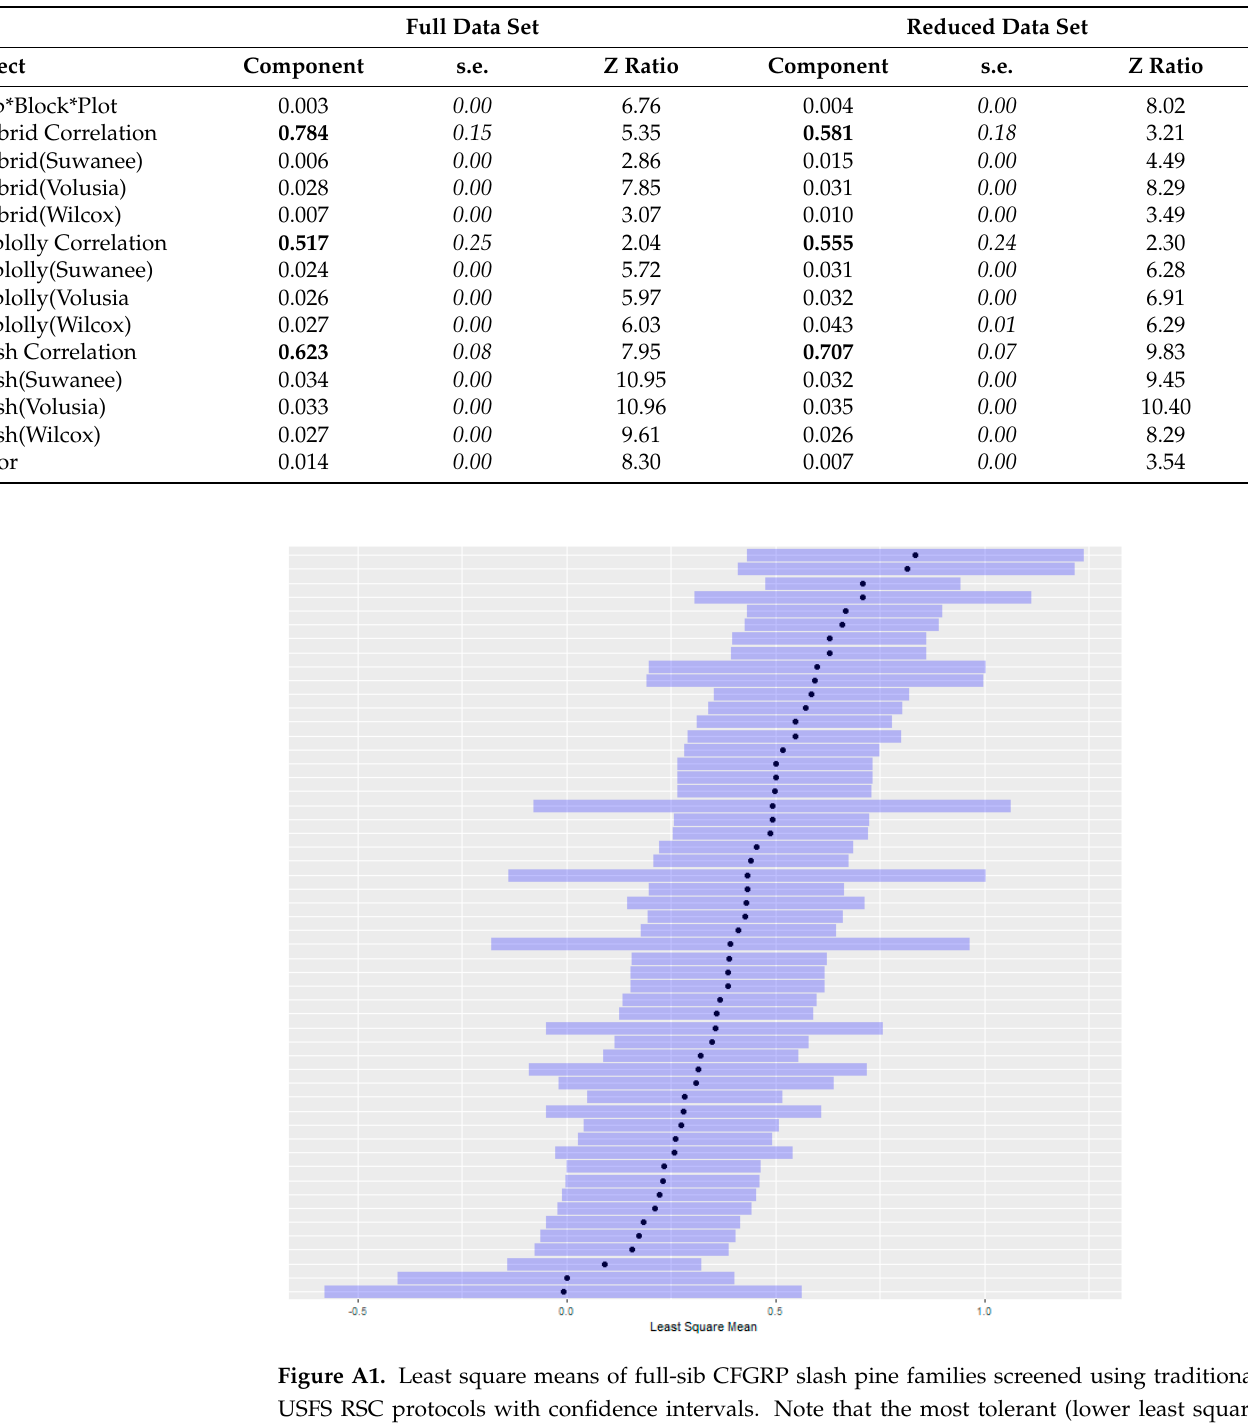
Table A1. Variance components for random effects of respective models, along with standard errors (italicized), genetic correlations in bold, and their Z ratios. Each effect is statistically significant.